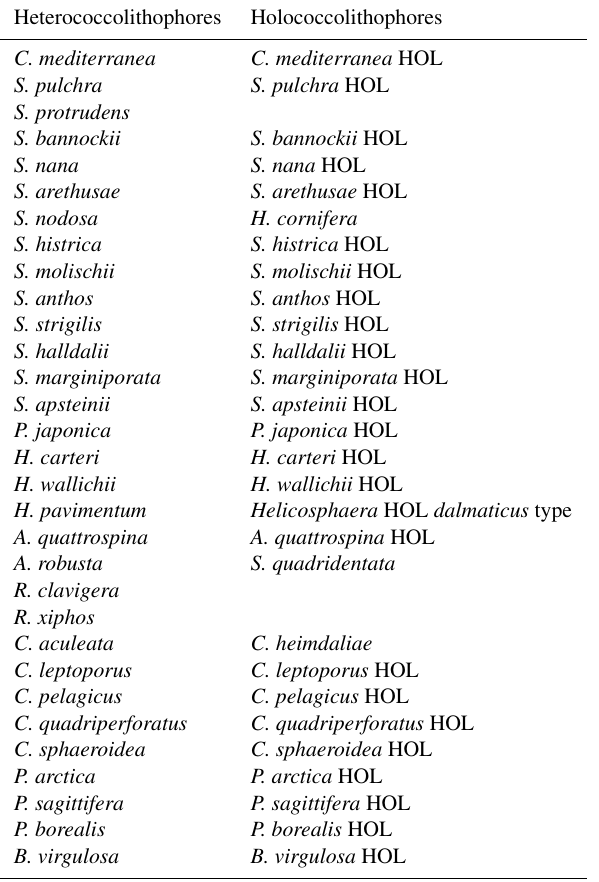
Table 2. Taxonomic units included in HOLP index.